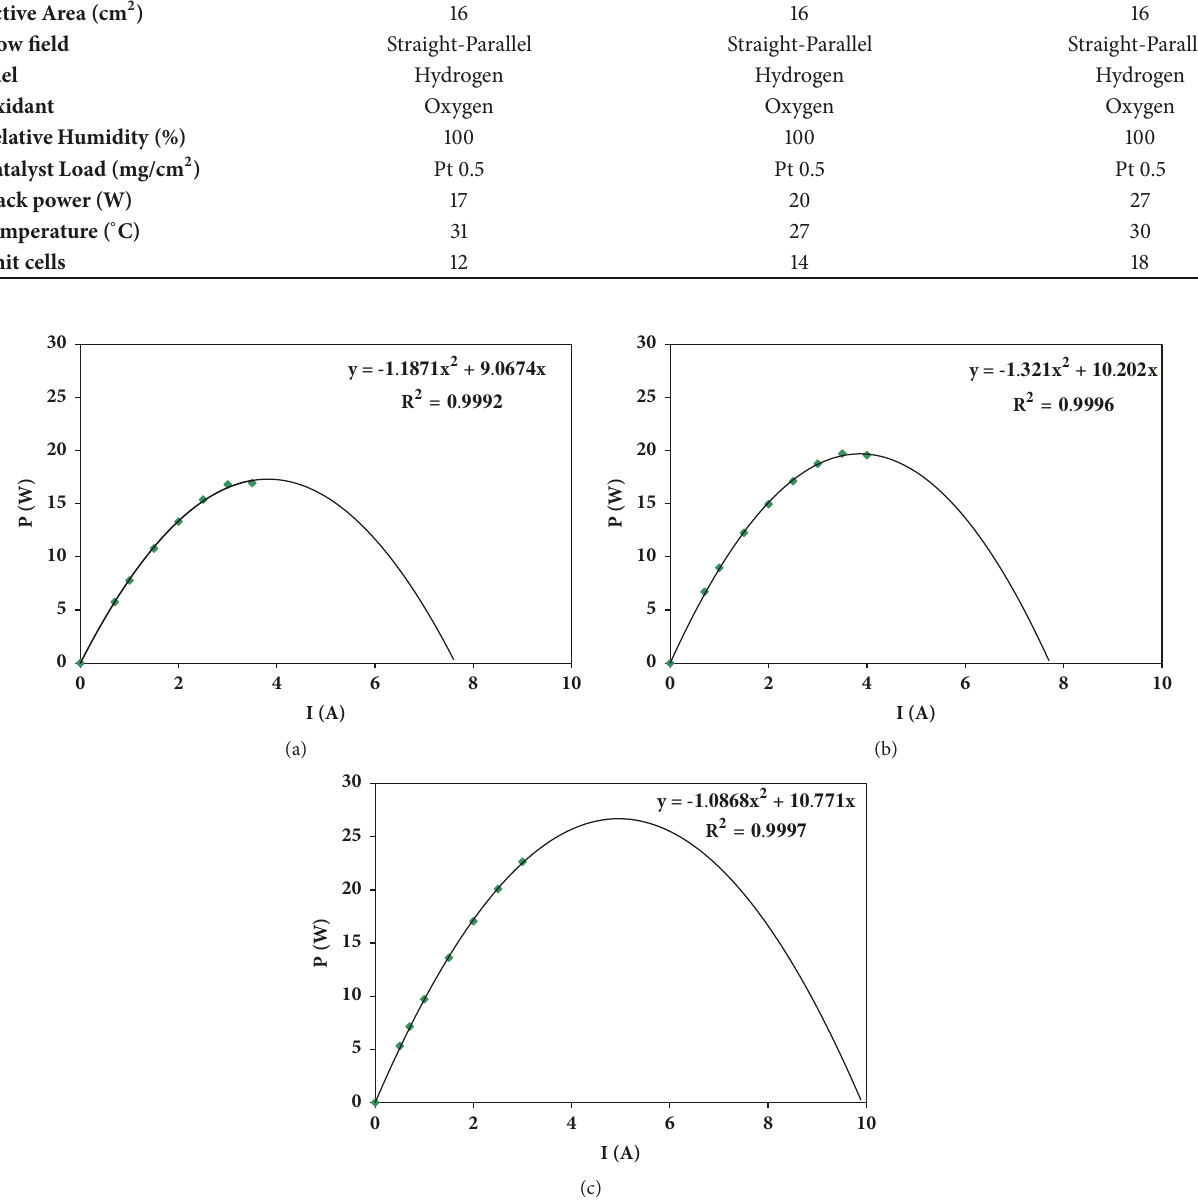
Figure 2: Graphical representation of power as a function of current intensity for fuel cells developed in the laboratory, the active area of which 16 cm 2 : (a) of 12; (b) of 14 y (c) of 18 unit